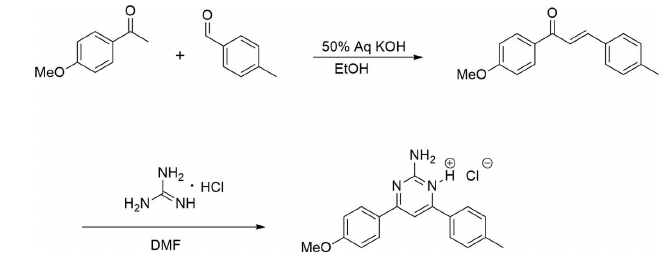
in the amino group (N3—H3 A ) and the chloride anion (orange dashed line in Fig. 2, Table 1), which links the mol- ecules into a chain along [001]. The three N—H (cid:2) (cid:2) (cid:2) Cl hydrogen bonds connect the molecules in helical manner along [001]. Six molecules are involved in one turn of the helix (Fig. 3).